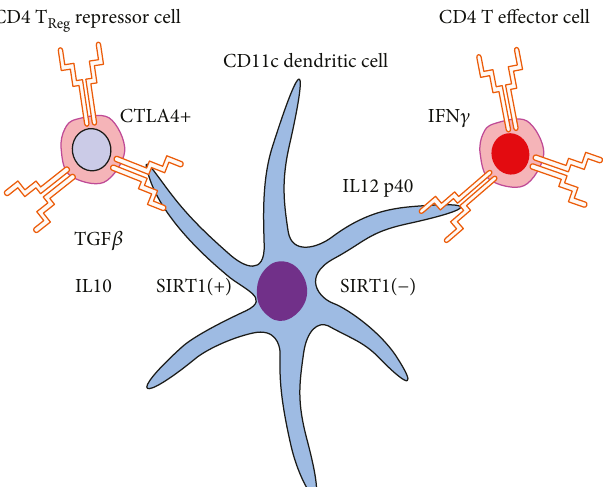
Figure 5: E ff ects of SIRT1 inhibition on dendritic and CD4 e ff ector and repressor immunity during sepsis. SIRT1 increases during the immunometabolic stage of sepsis coordinates innate tolerogenic dendritic cell and CD4 T cell repressor and immune inhibitory IL10 and TGF β cytokines. SIRT1 therapeutic inhibition reverses both the innate to adaptive immune CD4 e ff ector cell interactions and e ff ector immune cytokines (e.g., IL12 p40 and interferon γ levels). It is unclear in which cell or cell nuclear SIRT1 is acting to guard resistance and tolerant sepsis in fl ammatory